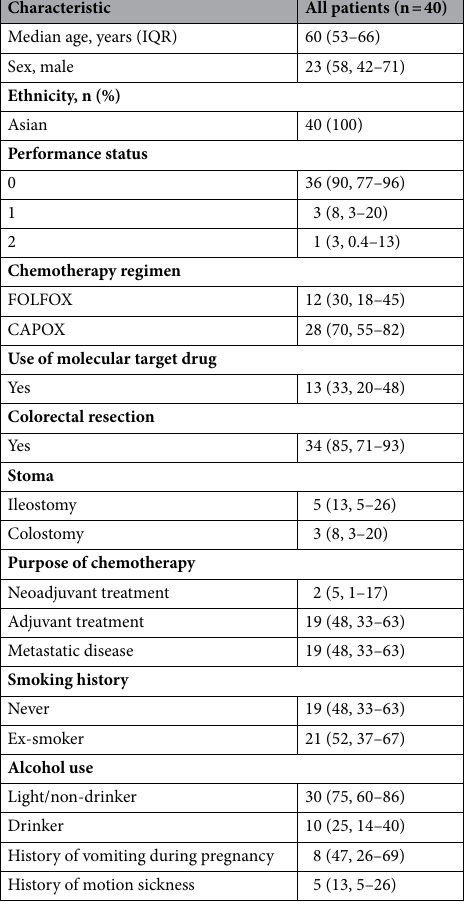
Table 1. Patient characteristics. IQR interquartile range. Data are given as n (%, confidence interval) unless otherwise noted.